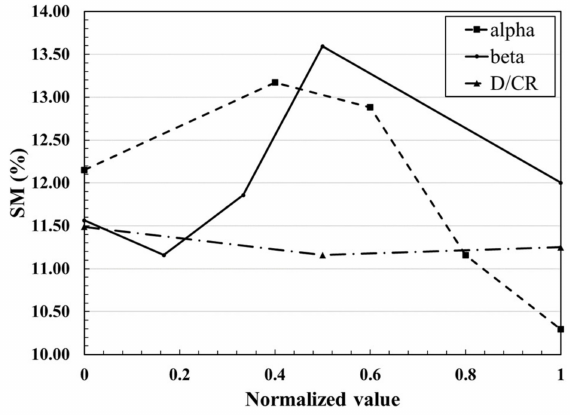
Figure 13. Sensitivity analysis of geometric